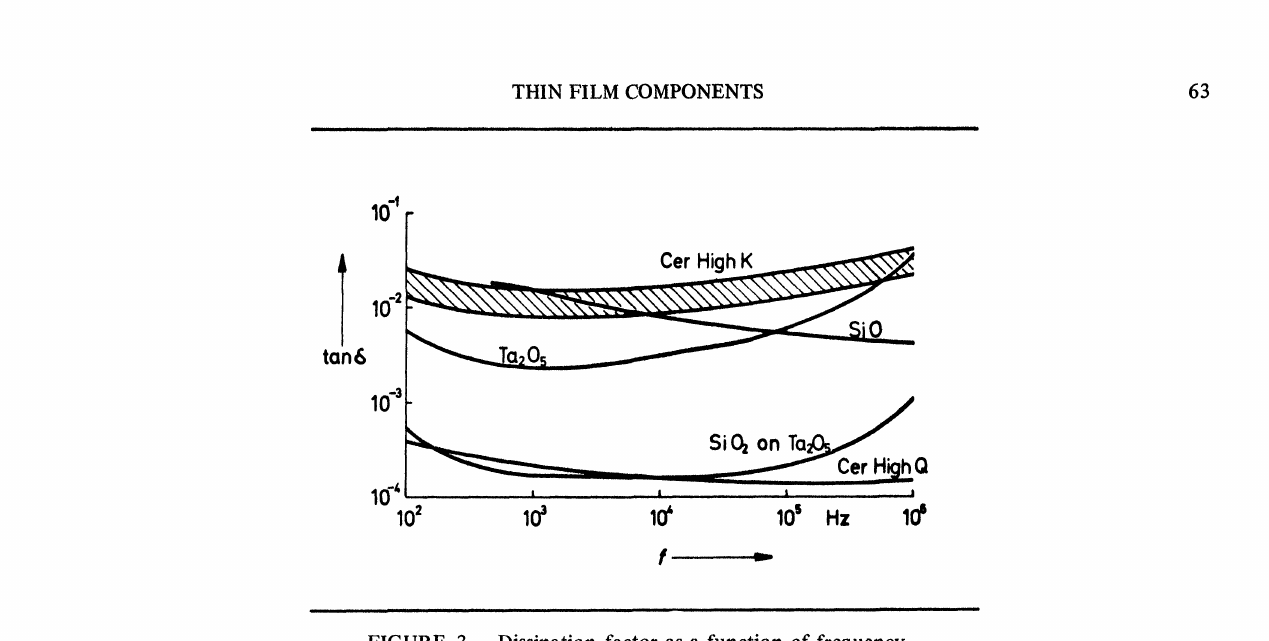
FIGURE 3 Dissipation factor as a function of frequency.